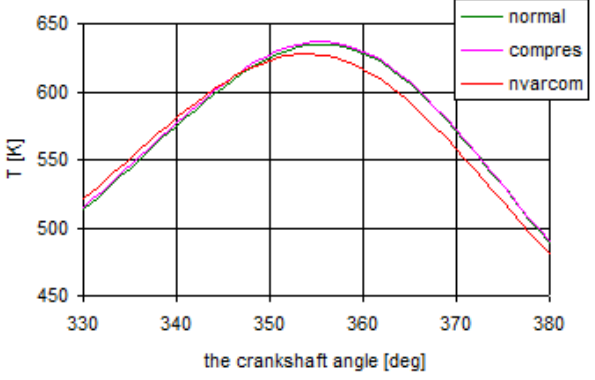
Fig. 5. The fragment of the computed temperature values dependence on the crankshaft rotation angle for different conditions of air flow and crank- shaft temporary rotational speed